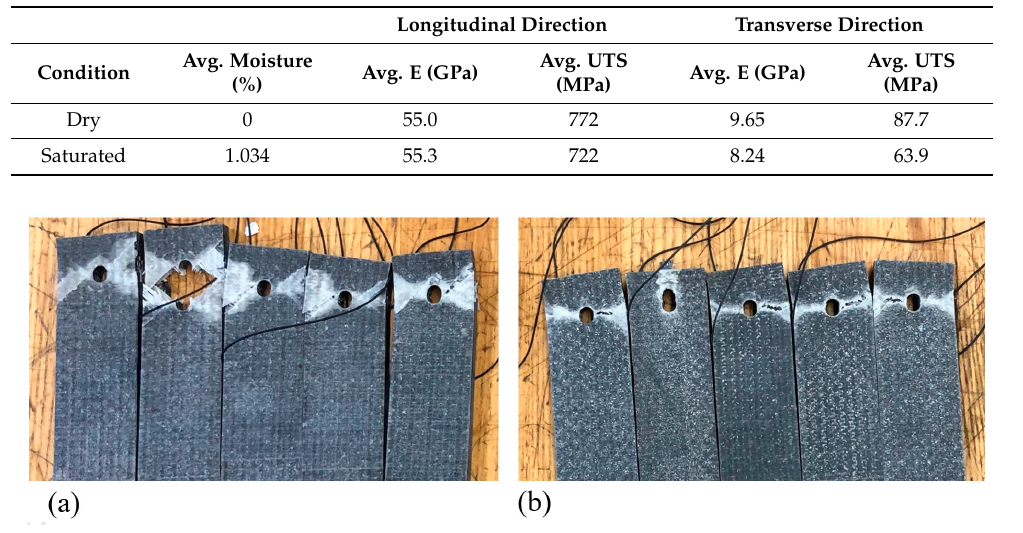
Figure 6. Force-displacement curves in longitudinal loading for ( a ) dry coupons and ( b ) saturated coupons. 3.2. Modeling Results The elastic properties for the carbon-reinforced lamina and glass-reinforced lamina obtained from the best-fit optimization in step 1 of the modeling investigation are shown in Table 6.